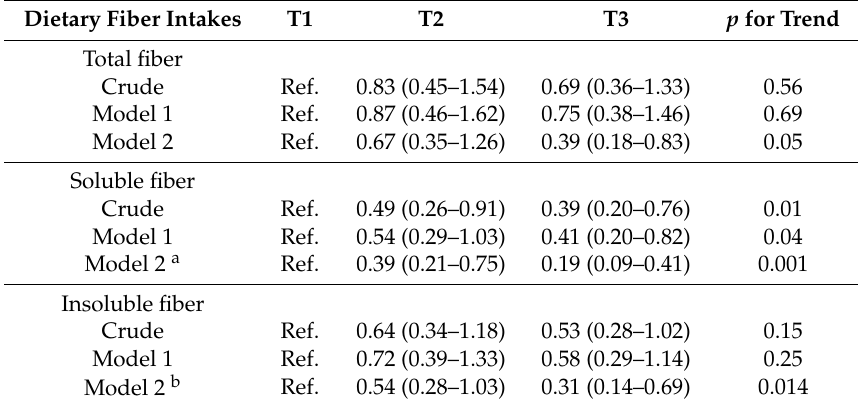
Table 2. The hazard ratio (95% CI) of coronary heart disease across tertiles of dietary fiber and its categories.